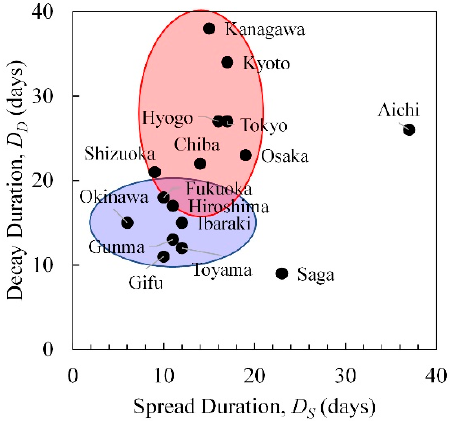
Figure 3. Relationship between the durations of spread and decay (in days). The red ellipse highlights prefectures with relatively high population densities, while the blue ellipse highlights those with lower population